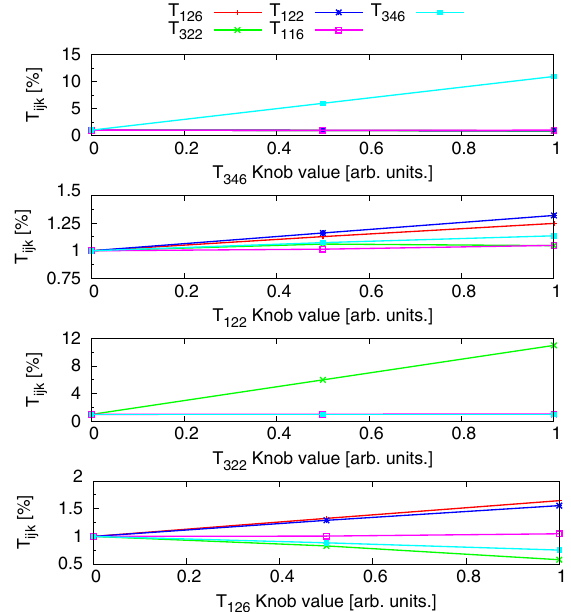
FIG. 2. Variation of T 126 (red), T 322 (green), T 122 (blue) and T 346 (cyan) correlations when scanning the T 346 knobs from bottom to top